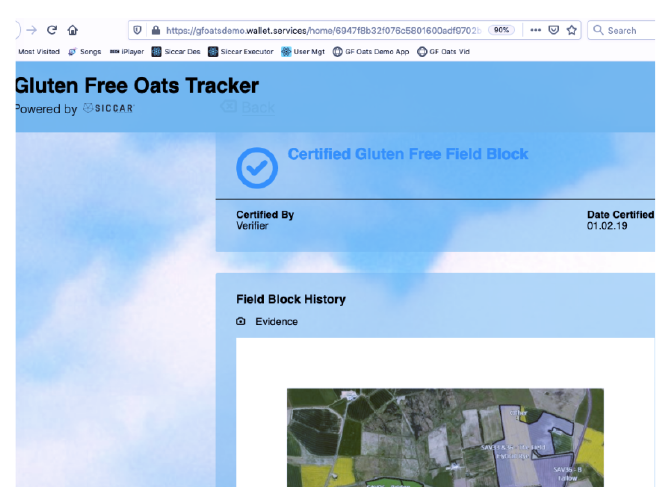
Figure 5: Unencrypted data defined as public, and so viewable to the API, and powering a mobile-friendly web app for consumers to view.